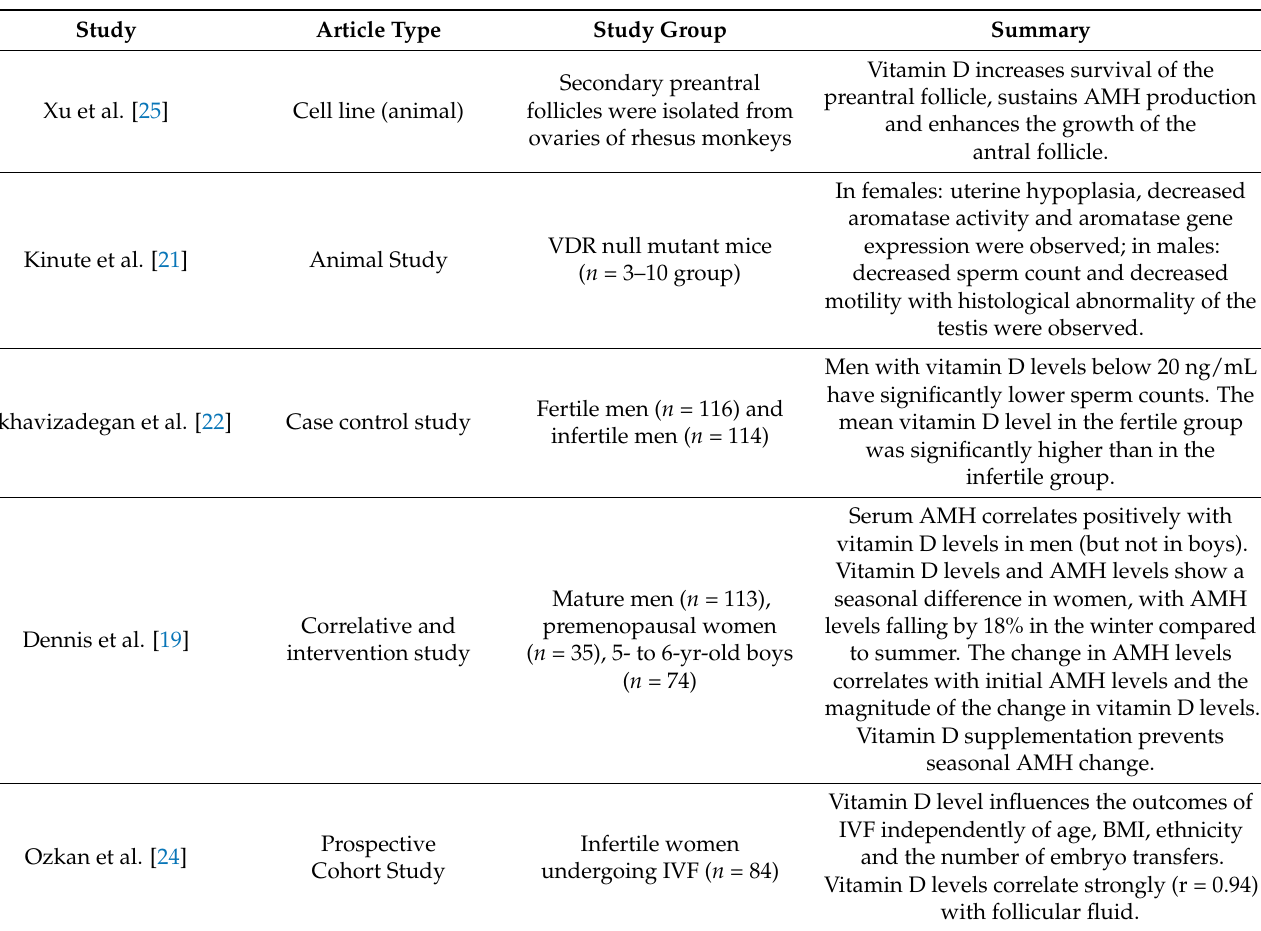
Table 1. Influence of Vitamin D on fertility and in vitro